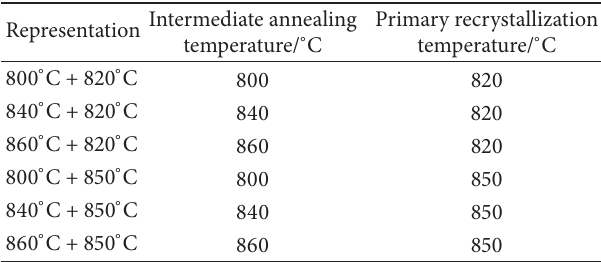
Table 1: Heat treatment